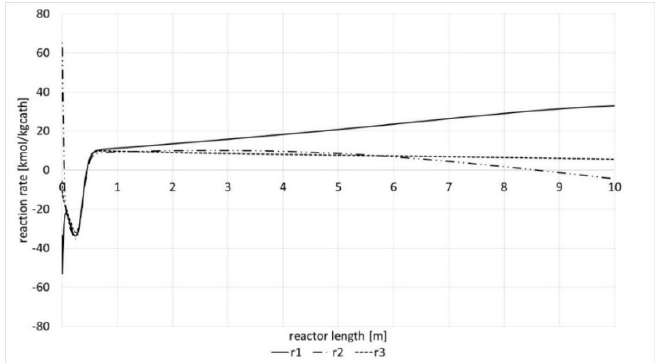
Figure 9. The intrinsic reaction rates for three reactions with the length of the reformer tubes at given inlet process conditions from Table 3.